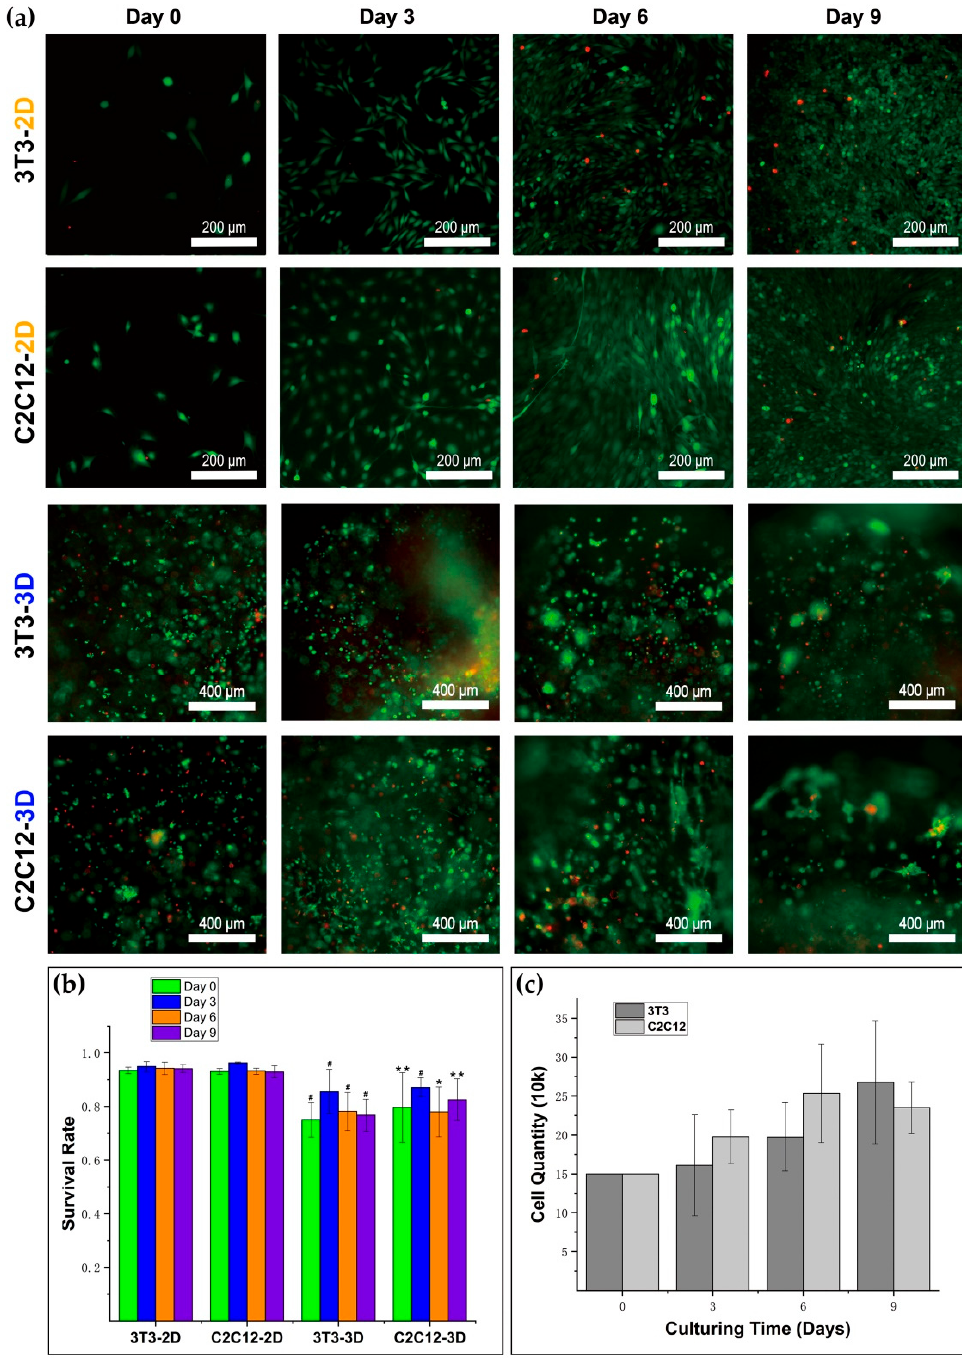
Figure 4. Viability and proliferation of cells in 2D and 3D. ( a ) Live/dead test conducted on 3T3 and C2C12 in a 2D petri dish (TCPS control) and 3D dextran hydrogel; ( b ) Survival rates of 3T3 and C2C12 from day 0 to day 9. The data were presented by mean ± SD; ( c ) Numbers of 3T3 and C2C12 cells in 3D from day 0 to day 9. The data were presented by mean ± SD; * p < 0.05, ** p < 0.03, and # p < 0.01 versus the corresponding 2D control samples.